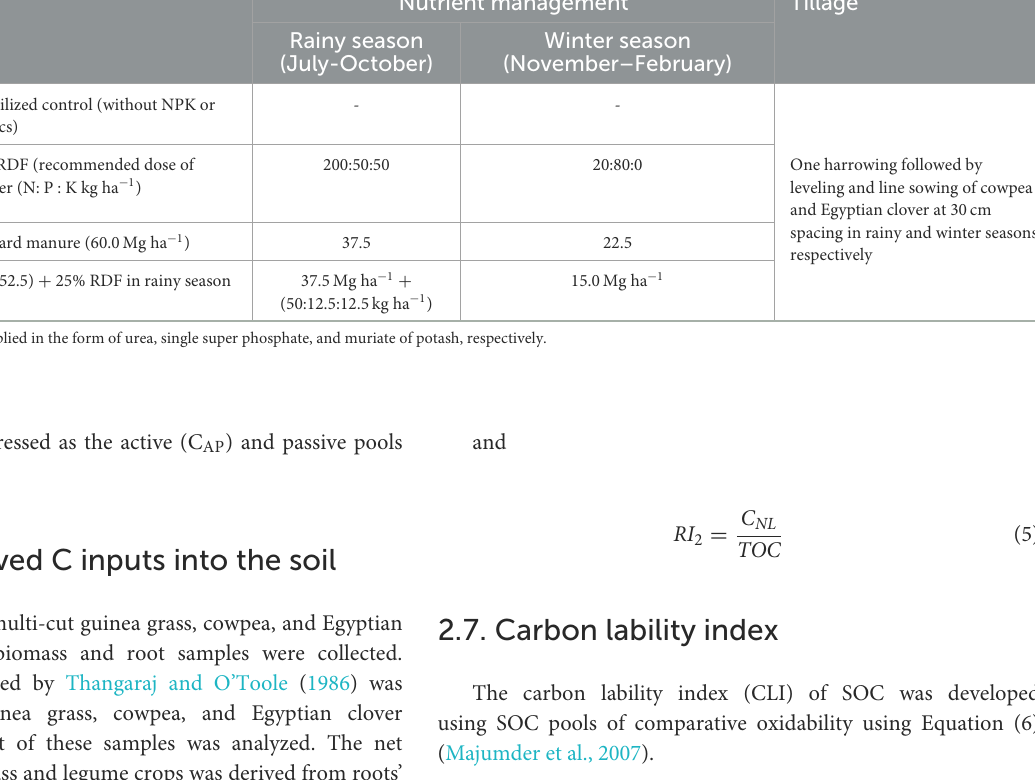
TABLE 1 Description of the management practices for guinea grass + (cowpea-Egyptian clover) cropping system. Treatments